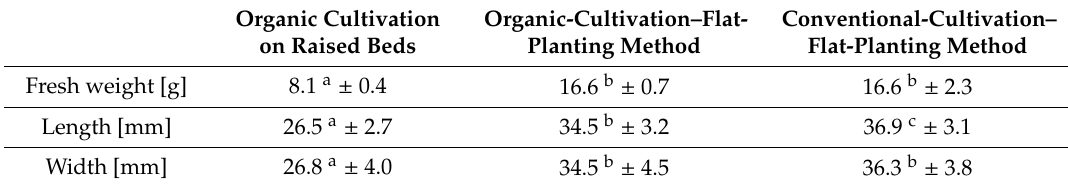
Table 2. Fruit dimensions on the day of